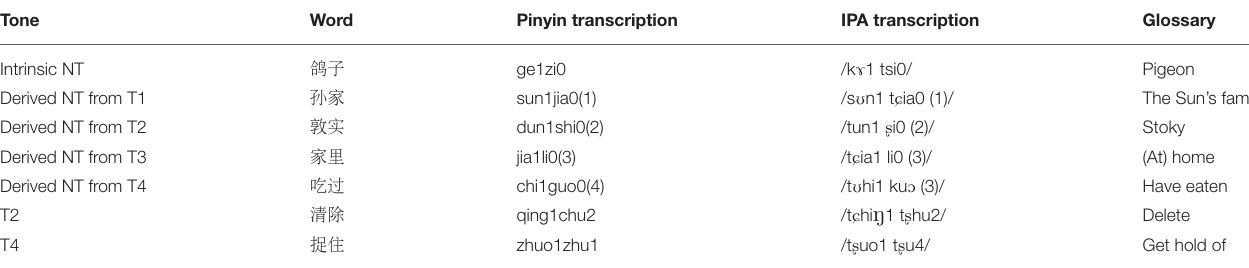
TABLE 1 | Examples of stimuli in each condition.